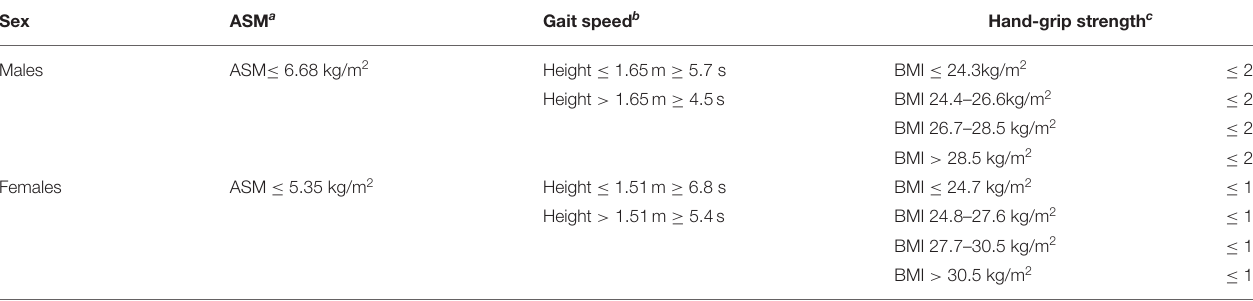
TABLE 1 | Components and cut-off points used for the diagnosis of sarcopenia. Sex ASM a Gait speed b Hand-grip strength c Males ASM ≤ 6.68 kg/m 2 Height ≤ 1.65m ≥ 5.7 s BMI ≤ 24.3kg/m 2 ≤ 22 Height > 1.65m ≥ 4.5s BMI 24.4–26.6kg/m 2